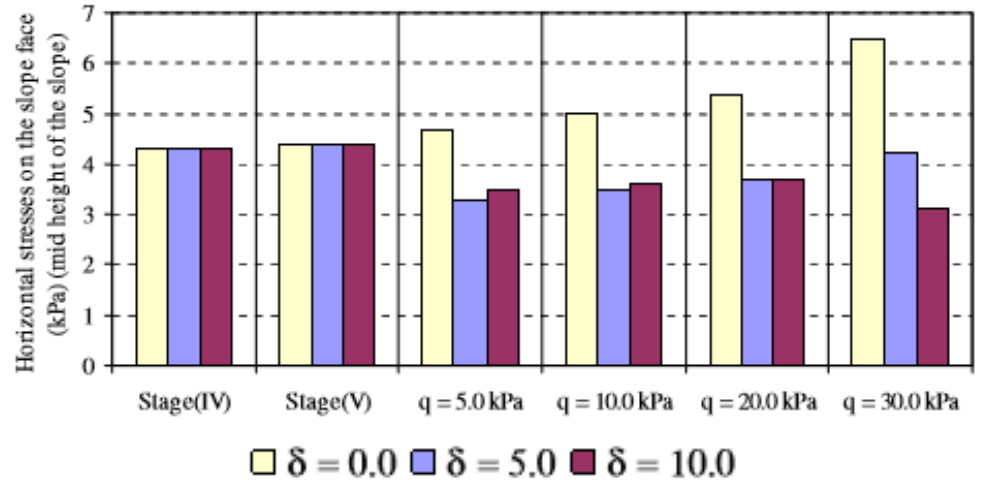
Figure 18. Influence of nail inclination on the slope face horizontal stresses at mid height of slope.